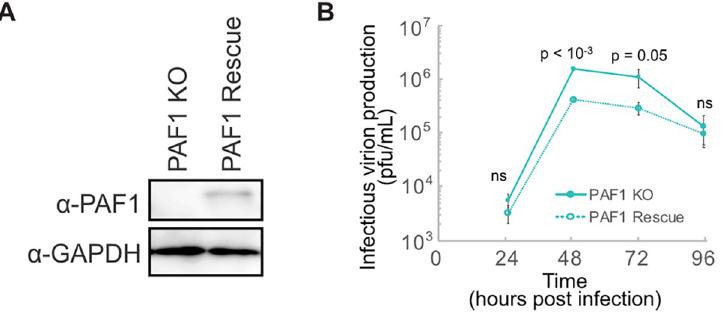
Fig 1. PAF1 restricts DENV2 infectious virion production. (A) Immunoblot analysis of PAF1 expression in PAF1 KO and rescue A549 cells. GAPDH is a loading control. (B) DENV2 replication in PAF1 KO and rescue cells, MOI 0.1. Data from three independent biological replicates are plotted as mean values +/- standard deviation. P values were calculated using a paired, one-tailed Student’s t-test. Abbreviations: plaque forming units (pfu), not statistically significant